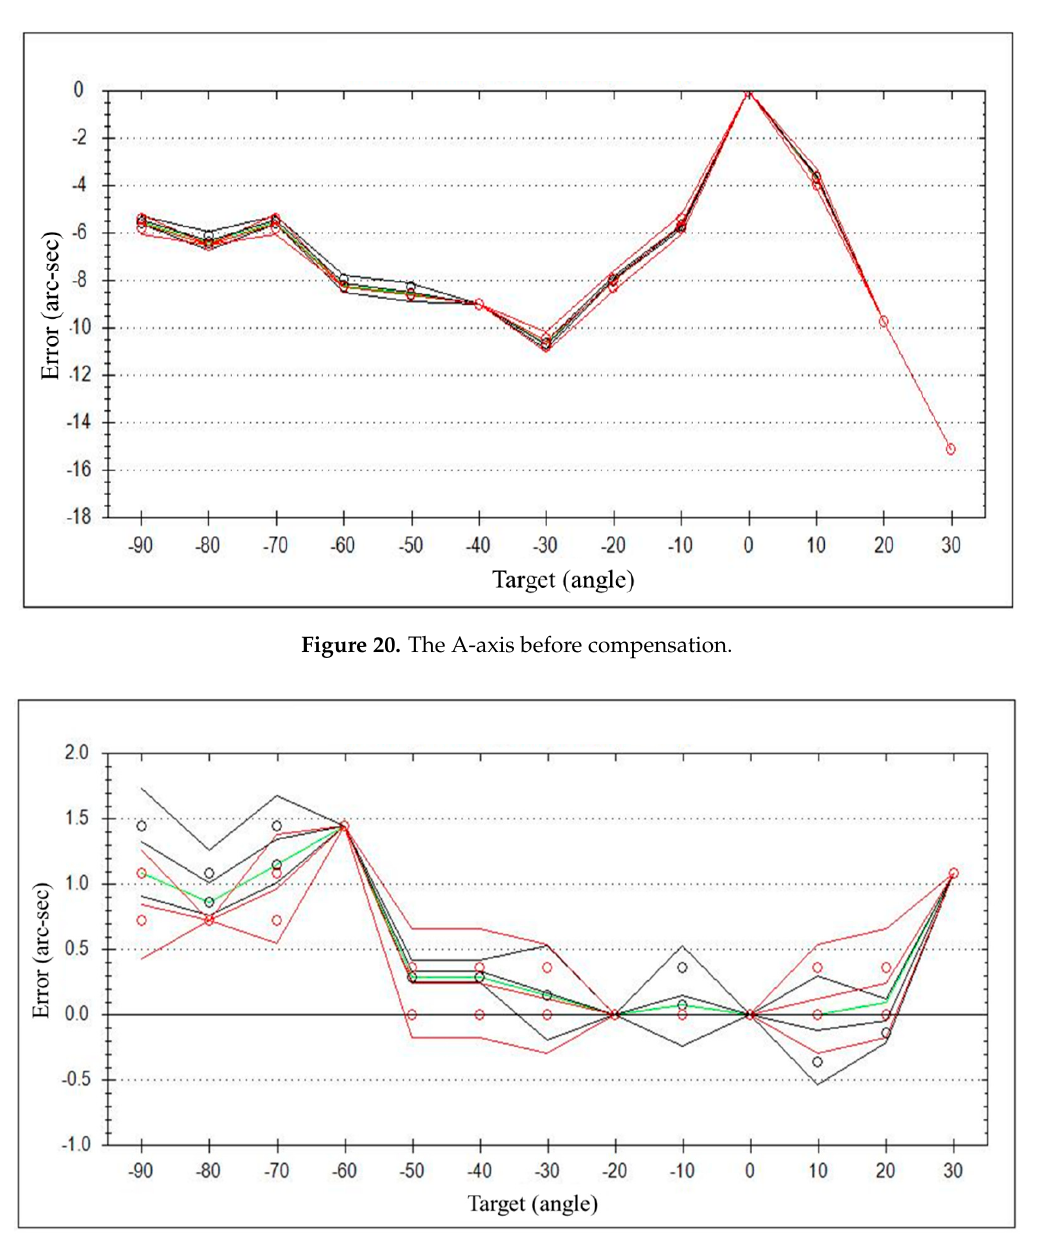
Figure 21. The A-axis after compensation.